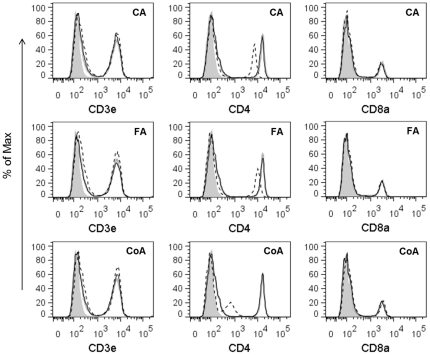
The competitive binding of polyphenols and anti-CD4 antibody to cell-surface CD4.Fresh splenocytes were pre-incubated with various polyphenols. After blocking the Fc receptors, splenocytes were incubated with anti-CD3e-PE, anti-CD4-APC, anti-CD8a-FITC, or isotype-matched control mAbs. The interaction between cell-surface receptors and monoclonal antibodies was examined using FACS. Grey shading represents the control cells with control antibody; grey lines represent the control cells with functional antibody; black continuous lines represent the monomer phenylpropanoic acids-treated cells with functional antibody; and black dashed lines represent the polymerised polyphenols-treated cells with functional antibody. The data shown are representative of 3 independent experiments.